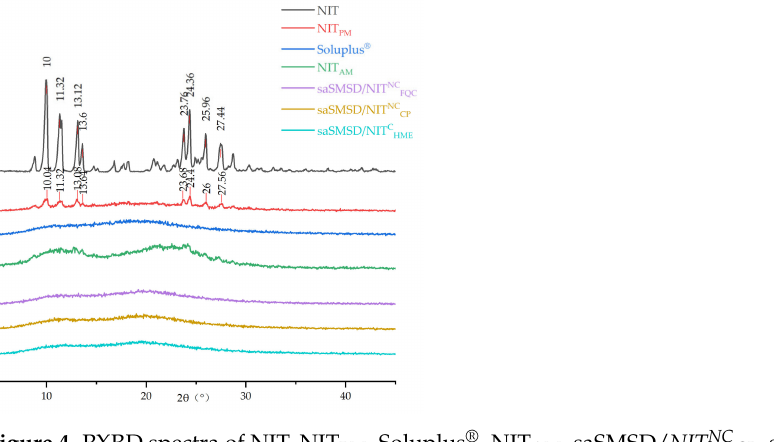
Figure 4. PXRD spectra of NIT, NIT PM , Soluplus ® , NIT AM , saSMSD/ NIT NC CP , saSMSD/ NIT NC FQC , saSMSD/ NIT C HME